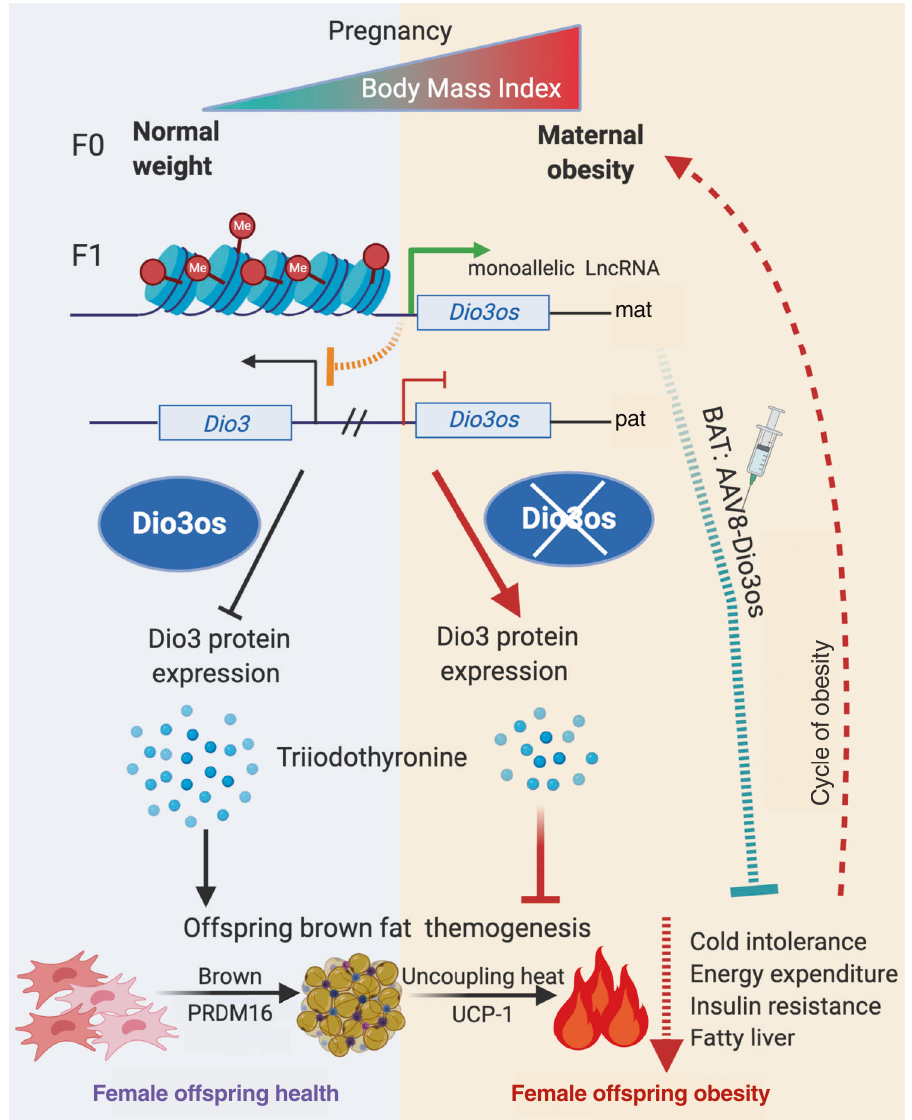
Fig. 9 Diagram summaries that maternal obesity impairs thermogenesis and energy expenditure of brown adipose tissue (BAT), predisposing female offspring to obesity and metabolic dysfunctions. Dio3os , a maternally imprinted long-coding RNA, has DNA hypermethylation in its promoter, which has an oocyte origin. The hypermethylation attributes to Dio3os inactivation in offspring BAT, which activates Dio3 and reduces thyroid hormone T3 action, leading to impaired PRDM16 activity and thermogenesis. Mouse BAT receiving AAV vector expressing Dio3os prevents MO female offspring from diet- induced obesity and glucose intolerance, providing a pharmaceutic opportunity to improve the metabolic health of offspring and intervene in a vicious maternal-daughter obesity